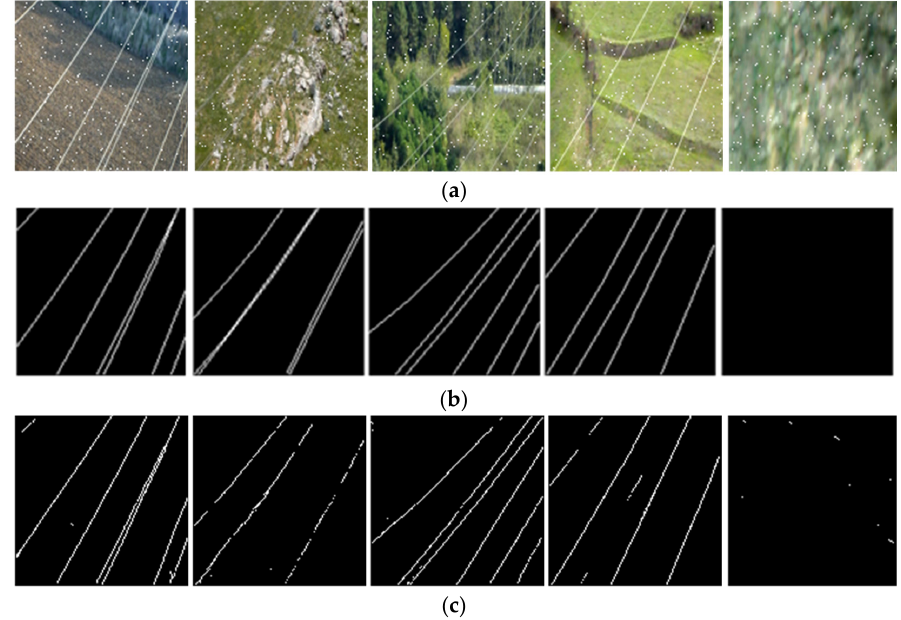
Figure 8. Test results in a snowfall environment. The first four show power line scene images, and the last one shows non-power line scene images (order from left to right). ( a ) Power line images in a snowfall environment. ( b ) Ground Truth. ( c ) The prediction results of the proposed method.